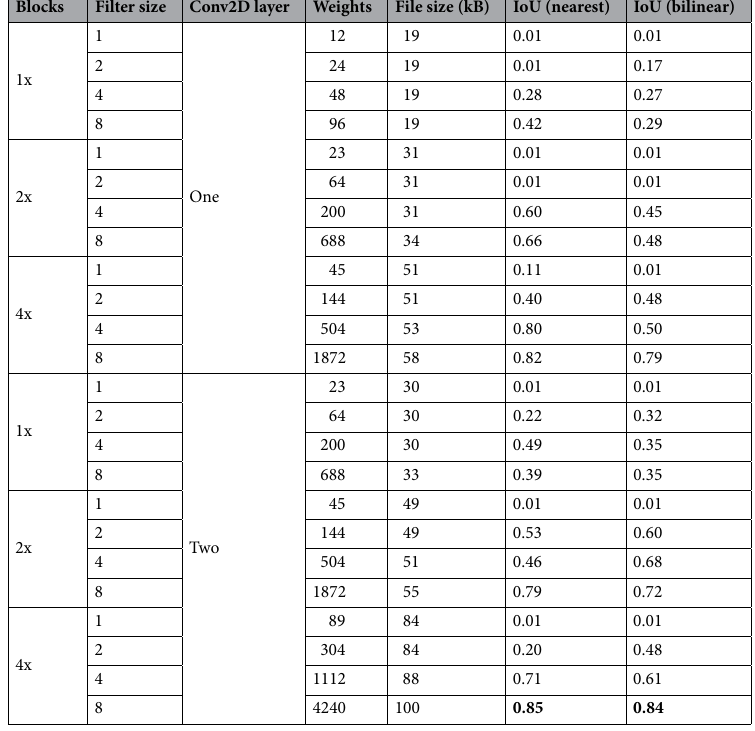
Table 1. Overview of all decoder configurations tested. Significant values are in